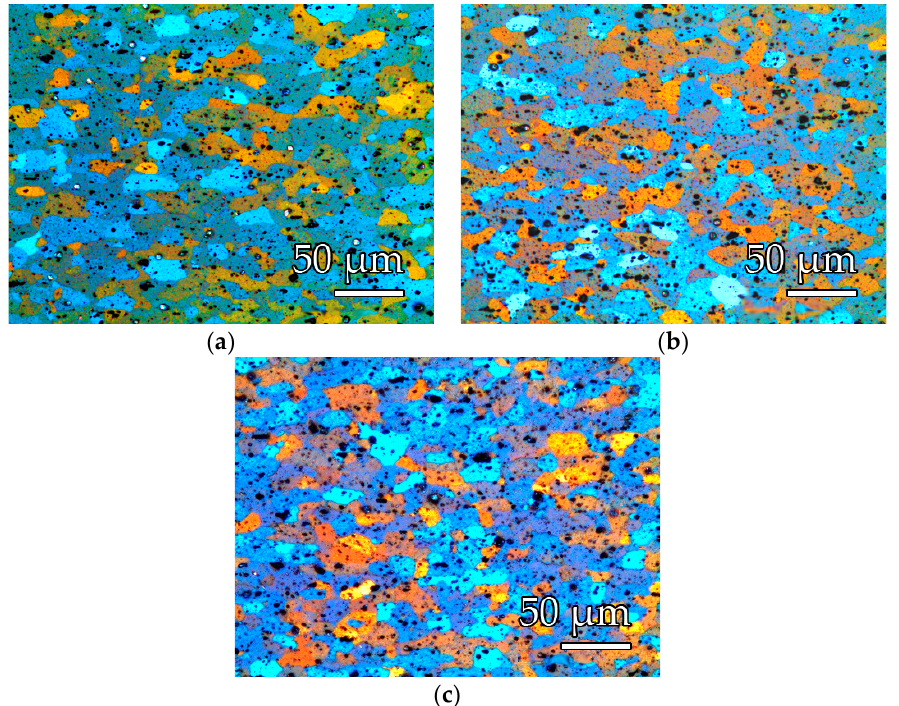
Figure 8. EN-AW5754 metallographic images obtained after polishing and electrolytic anodizing with Barker reagent: ( a ) after PFA coating, ( b ) after Quanta laser decoating, ( c ) after SPI laser decoating. Table 6. ASTM grain size, Vickers hardness (HV), and % area of constituent particles of EN AW 5754 alloy in various states.